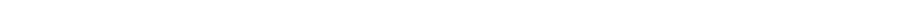
Figure 3. The sample text written by Rabindranath Tagore